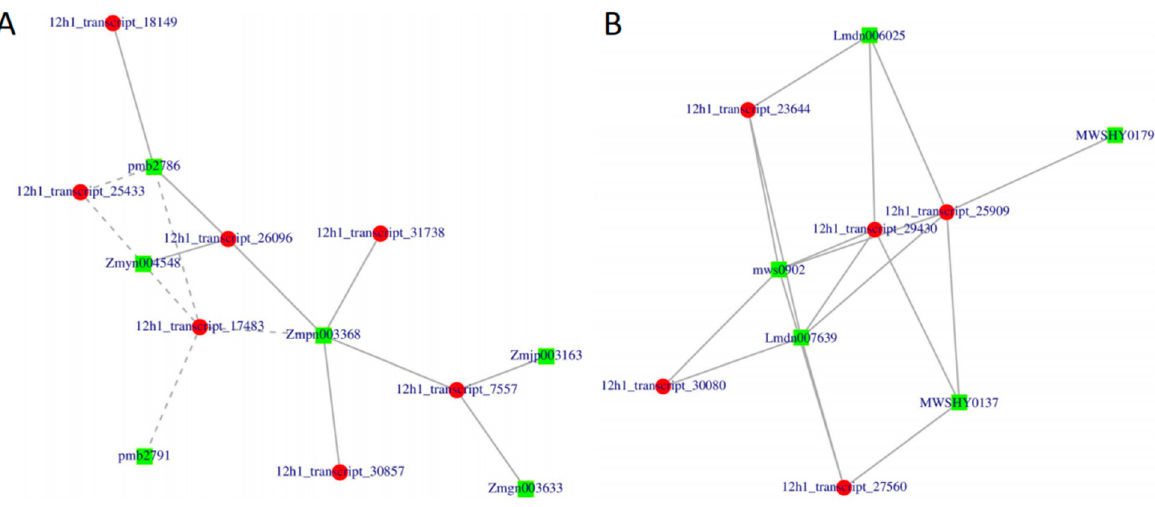
Figure 7. Correlation network of the DEGs and DEMs. Red represents transcripts, and green represents metabolites. ( A ) Flavonoid biosynthesis. ( B ) alpha-Linolenic acid metabolism.